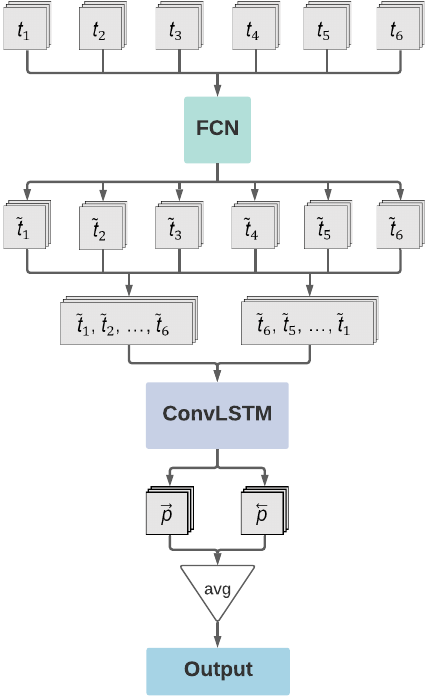
Figure 5. Schema of the FCN+long short-term memory (LSTM) model. Image tiles t i of one date i pass the FCN independently. The outputs ˜ t i are then stacked in forward and reversed chronological order. Each stack passes the ConvLSTM layer independently, and the respective predictions ←− p are merged via averaging to the final